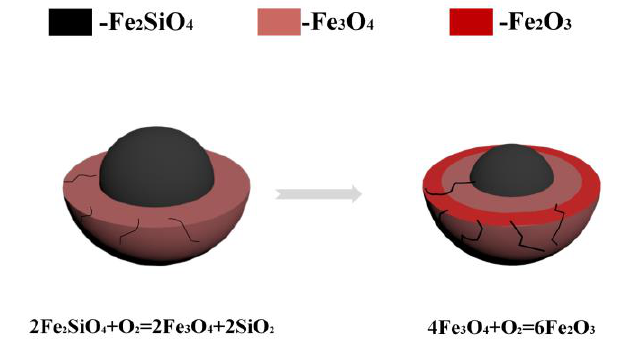
Figure 12. Oxidation mechanism of nickel slag.